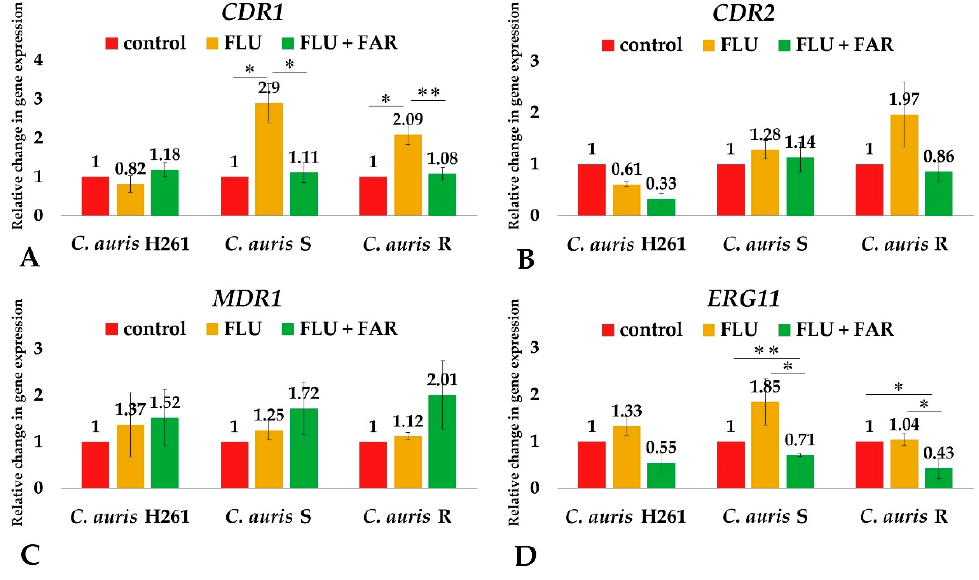
Figure 4. Relative change expression of the CDR1 ( A ), CDR2 ( B ), MDR1 ( C ), and ERG11 ( D ) genes determined by qPCR. The expression of genes was calculated using the 2 − ∆∆ CT method with respect to the housekeeping gene ACT1 . The level of gene expression was examined in the presence of subinhibitory concentration of FLU: 0.06 µ g/mL for C. auris H261, 8 µ g/mL for C. auris S, and 32 µ g/mL for C. auris R (the second column in each chart); a combination of 200 µ M FAR and subinhibitory concentration of FLU (the third column in each chart). Values were compared to the control without any drugs (the first column in each chart) which was normalized to a value of 1. Data represent the average of 3 independent experiments performed in triplicate ± SD. p -values < 0.05 were considered significant: * < 0.05; ** < 0.01.